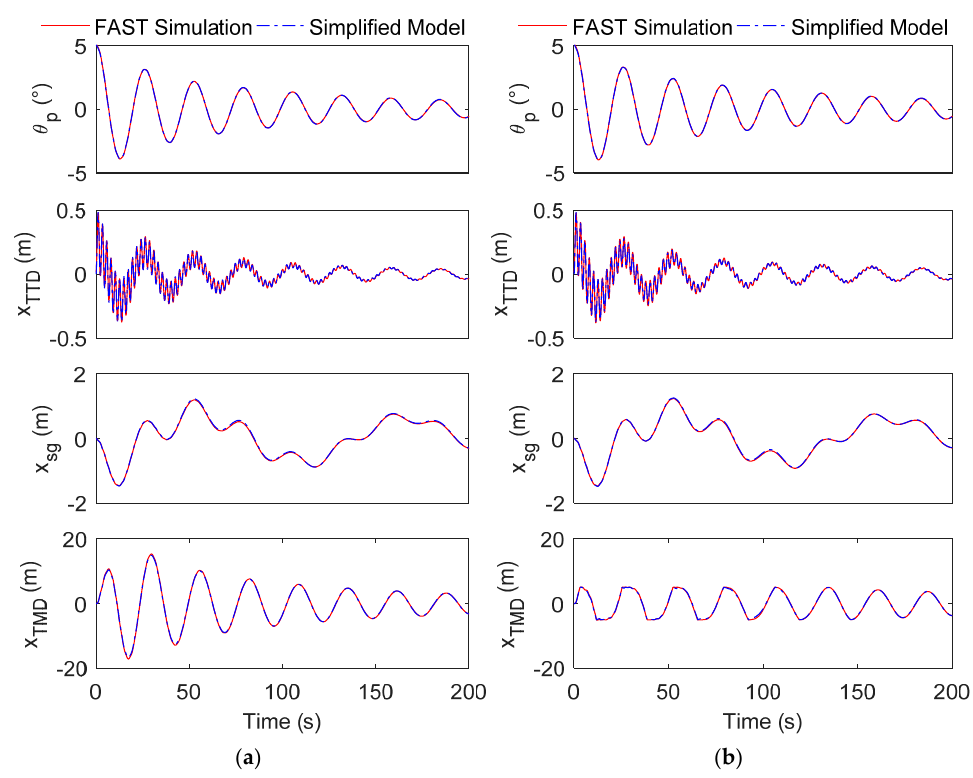
Figure 5. Comparison of 5° pitch free decay responses between the simplified model and FAST simulation with active TMD: ( a ) without TMD stops; and ( b ) with TMD stops.